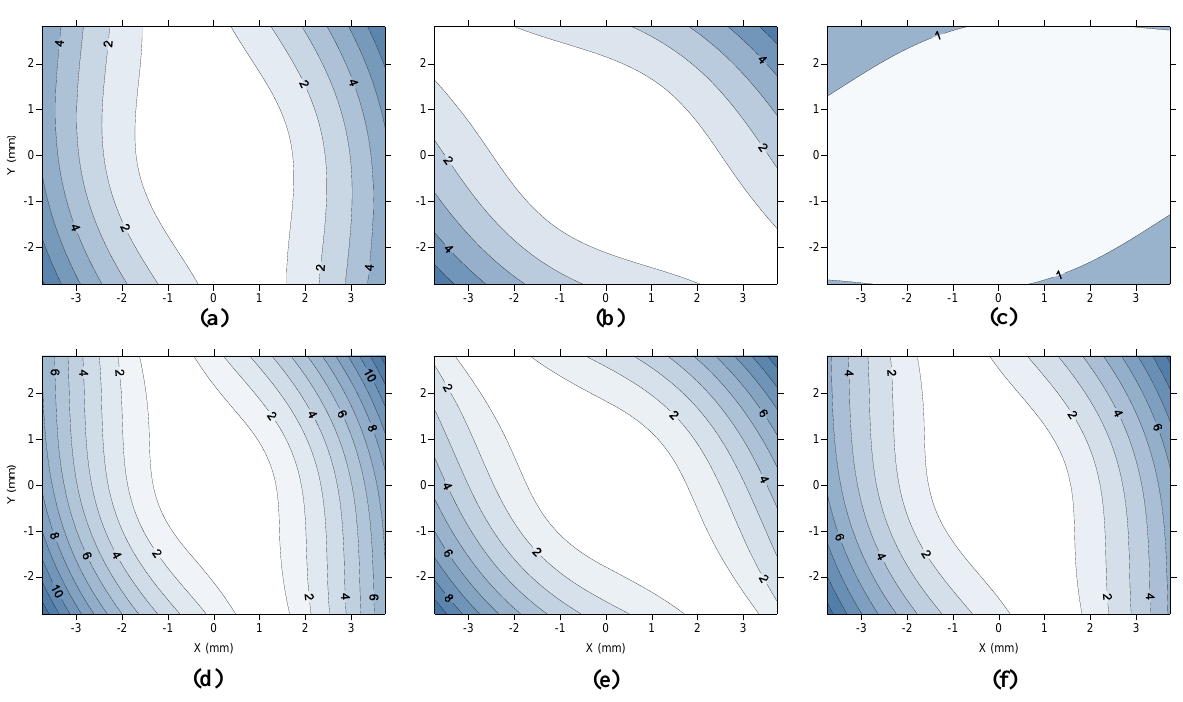
Figure 10. Tangential component of the decentering distortion (in microns) in cameras